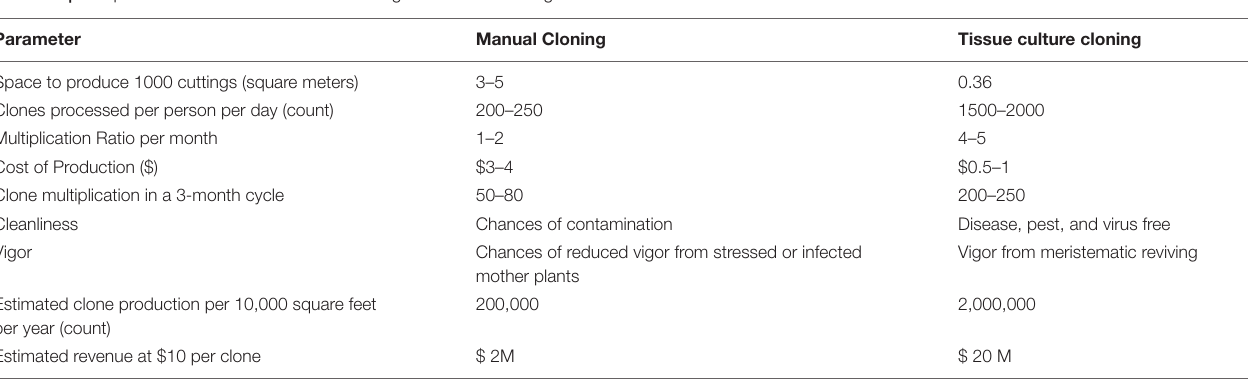
FIGURE 7 | A flow chart depicting different approaches that can be used to determine the genetic stability of in vitro regenerated or conserved cannabis plants, compared to its donor counterparts. TABLE 4 | Comparison between tissue culture cloning and manual cloning in